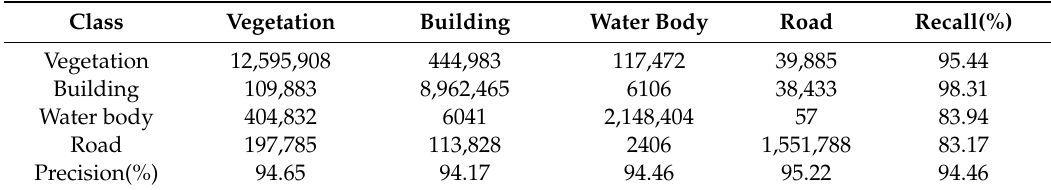
Table 1. Confusion matrix of